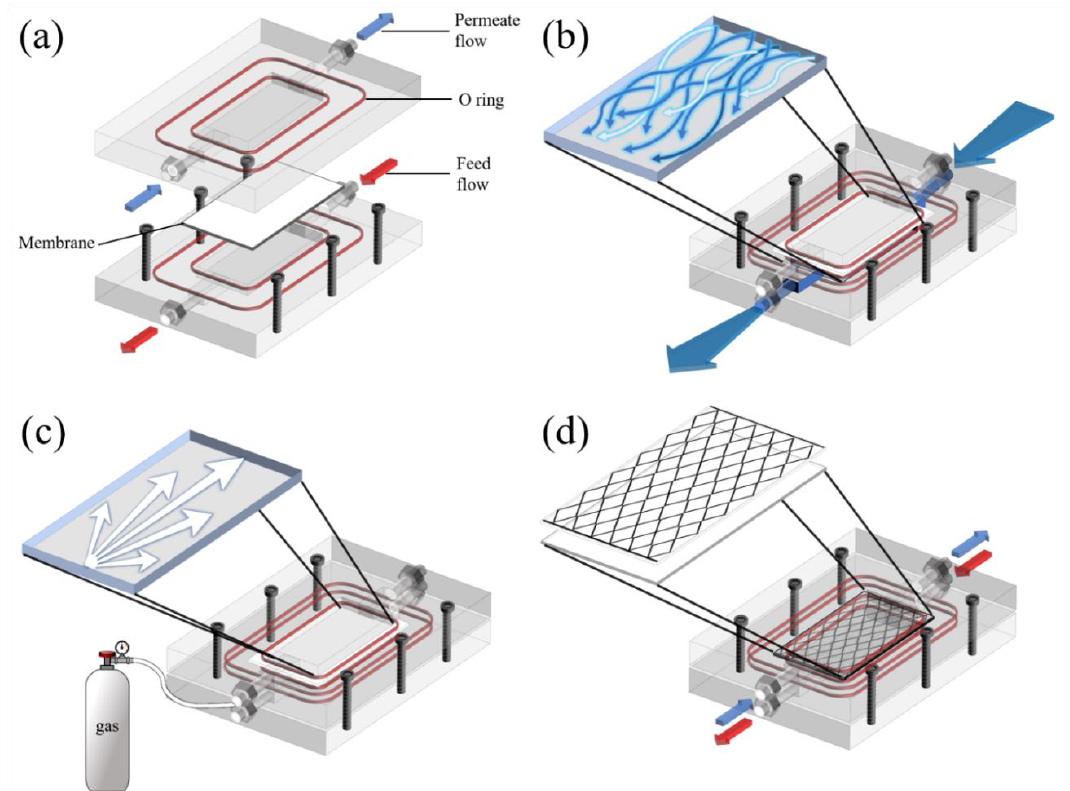
Figure 3. Schematic diagrams of ( a ) the DCMD module and fouling control methods; ( b ) water flushing was conducted for 1 min at 1 h intervals with a 2.5 L min −1 flowrate; ( c ) air backwashing was performed for 1 min every 1 h with 100 kPa of air pressure; and ( d ) a membrane spacer was made of 45° woven square patterned PLA.